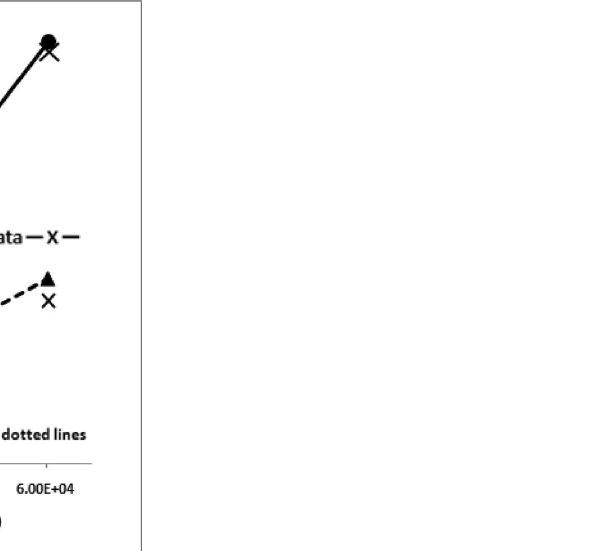
intermediate frequency ranges (around 1 to 100 Hz) with phase shift Ɵ tending to 90°. However the experimental data also in this case could be fitted only after putting Warburg component in the simulated electrical circuit (discussed in the forthcoming paragraphs). The impedance data plotted in Nyqist form (real vs imaginary impedance) provide much important and valuable information about the corroding interface. In view of this the data of Figs. 10, 11, 12 and 13 were also plotted in this form and are presented in Figs. 14, 15, 16 and 17. It is seen that the features of Nyquist plots for rebars exposed in chloride free and chloride added pore solutions significantly differ. The plots for the first group of samples (exposed in chloride free SPSL) are closure to straight lines forming about 45 o angle between the abscissa and ordinate axes. The plots for the second set of samples exposed in chloride added solutions on the other hand tend to form depressed semi circles. These characteristics of the plots are associated with a spread of relaxation times and represented by substituting a constant phase element (CPE) in place of pure capacitor in the equivalent electrical circuit 47 . The CPEs (constant phase elements) which are defined by frequency independ- ent phase angles are used for the parameterization of impedance values including non-ideal behavior of double layer, charge transfer resistance, ionic adsorption or diffusion across the corroding interface and uncompensated resistance(electrolytic ionic resistance (R 0 ) between the interface of the solution and the electrode surface). Many